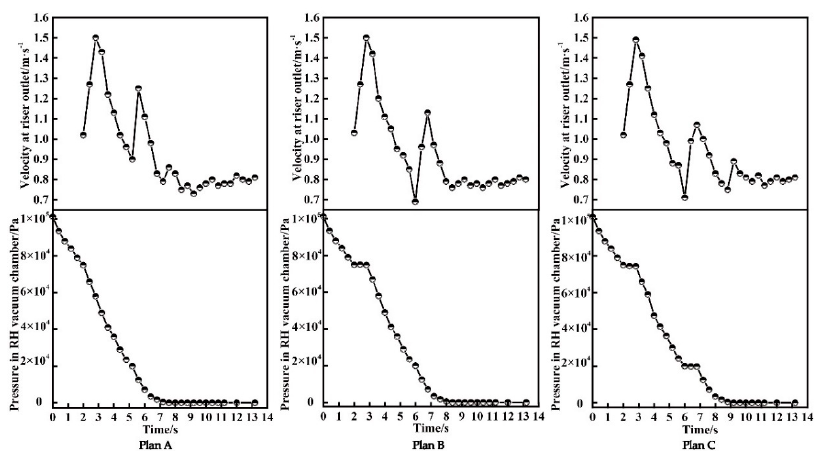
Figure 11. The speed of up-snorkel outlet monitored under different schemes.